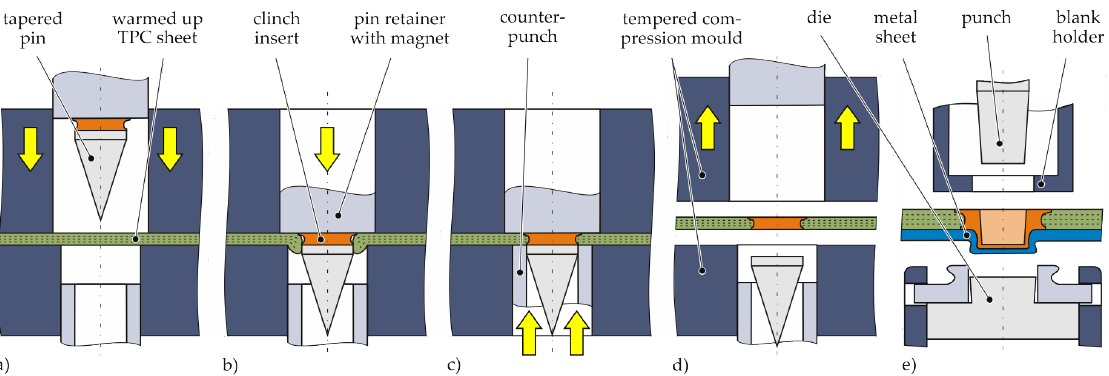
Figure 5. Schematic illustration of the Insert Clinching process: ( a ) compression mould closing, ( b ) movement of the pin tool, ( c ) recompressing the squeezed-out material by the counterpunch, ( d ) demoulding, and ( e ) subsequent standard clinching process with rigid or opening